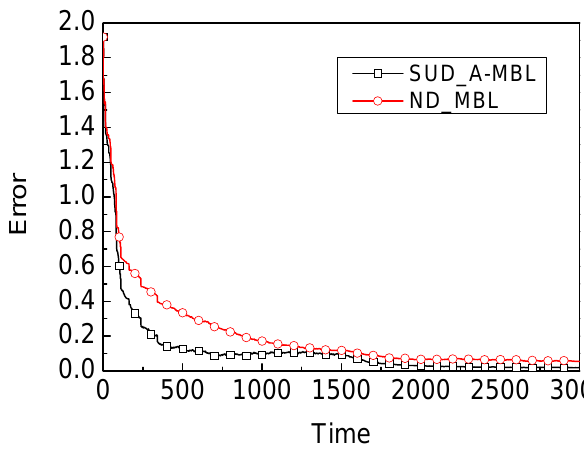
Figure 4. Accuracy comparison between SUD_A-MBL and ND_MBL.